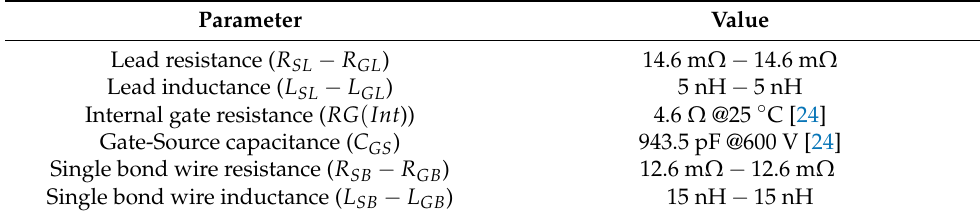
Table 1. Small-signal equivalent circuit